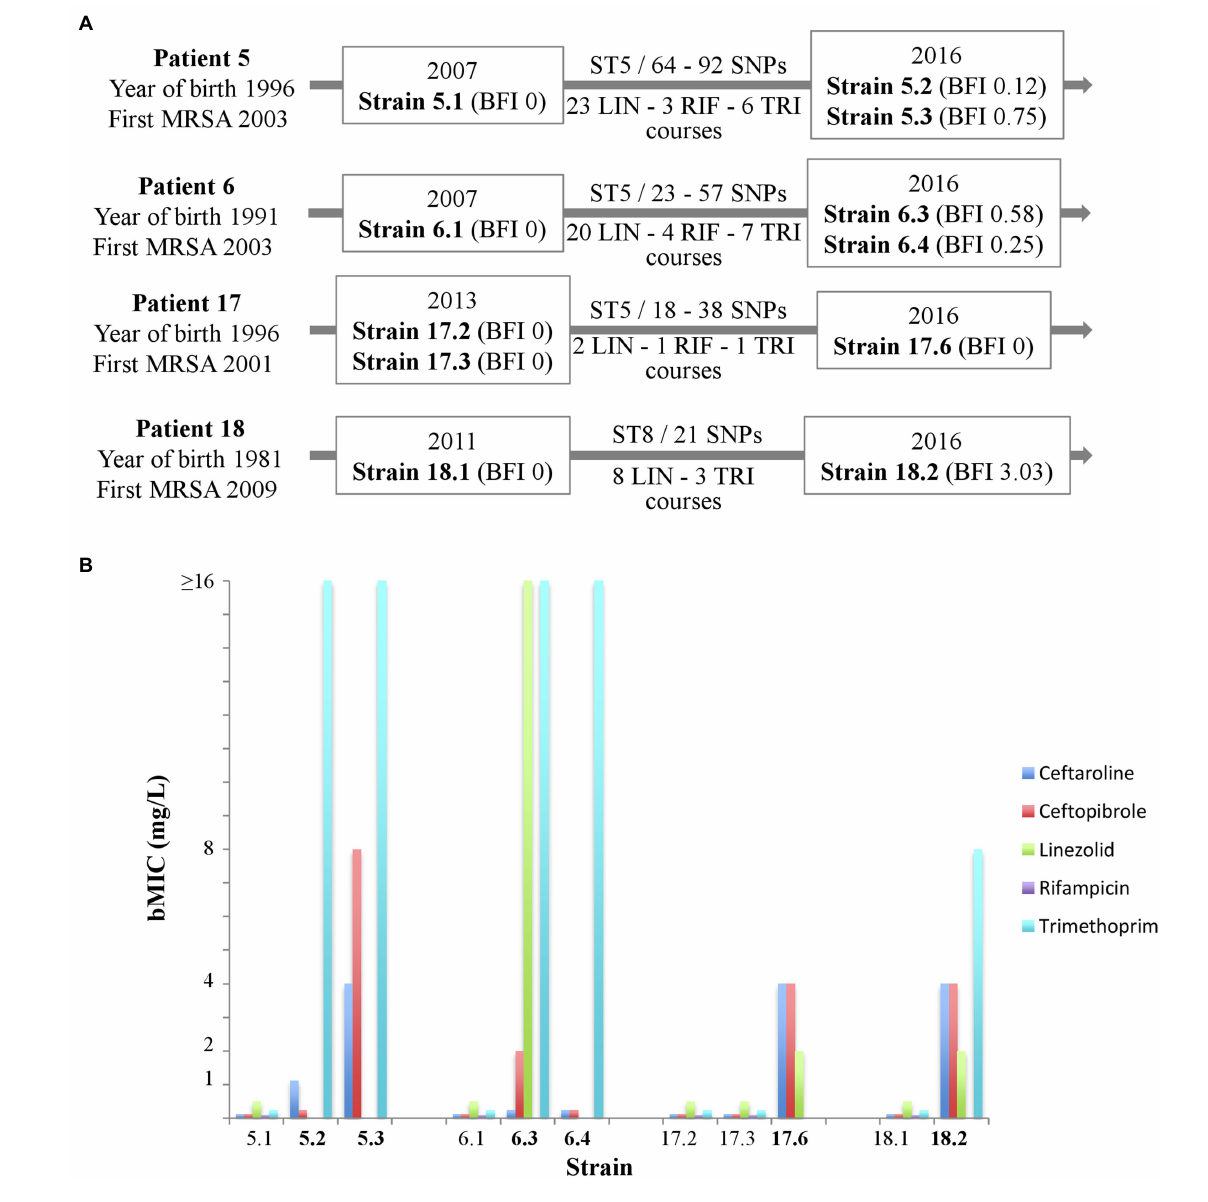
FIGURE 3 | Antibiofilmogram ® results for successively isolated MRSA strains in four cystic fibrosis patients (5 « early » strains; 6 « late » strains). (A) Schematic presentation of patients (designation, year of birth, and year of first colonization by MRSA), strains [year of isolation, strain designation, biofilm formation index (BFI) value, ST, single nucleotide polymorphism (SNP) number between successively isolated strains], and number of antimicrobial courses (LIN, linezolid; RIF, rifampicin; and TRI, trimethoprim). (B) Biofilm minimal inhibitory concentration (bMIC, mg/L) in 0.22 μm-filtered artificial sputum medium of five antibiotics for the 11 strains included (data are presented for strains categorized as susceptible to the antibiotic considered only). European Committee on Antimicrobial Susceptibility Testing (EUCAST) thresholds for susceptibility (at standard or high doses) are as follows: ceftaroline: 1 mg/L (threshold for pneumonia); ceftobiprole: 2 mg/L; linezolid: 4 mg/L; rifampicin: 0.5 mg/L; and trimethoprim: 4